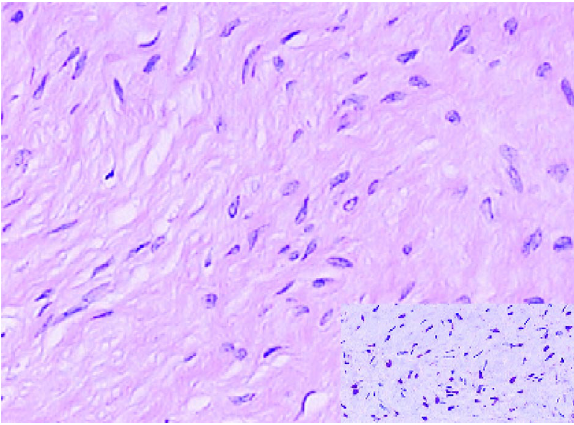
Figure 2 – Histological study showing spindle cells with fibril- lar cytoplasm and elongated nuclei characterizing diffuse neu- rofibroma (HE, X20). Insertion showing nuclear immunoreac- tivity to protein S100.